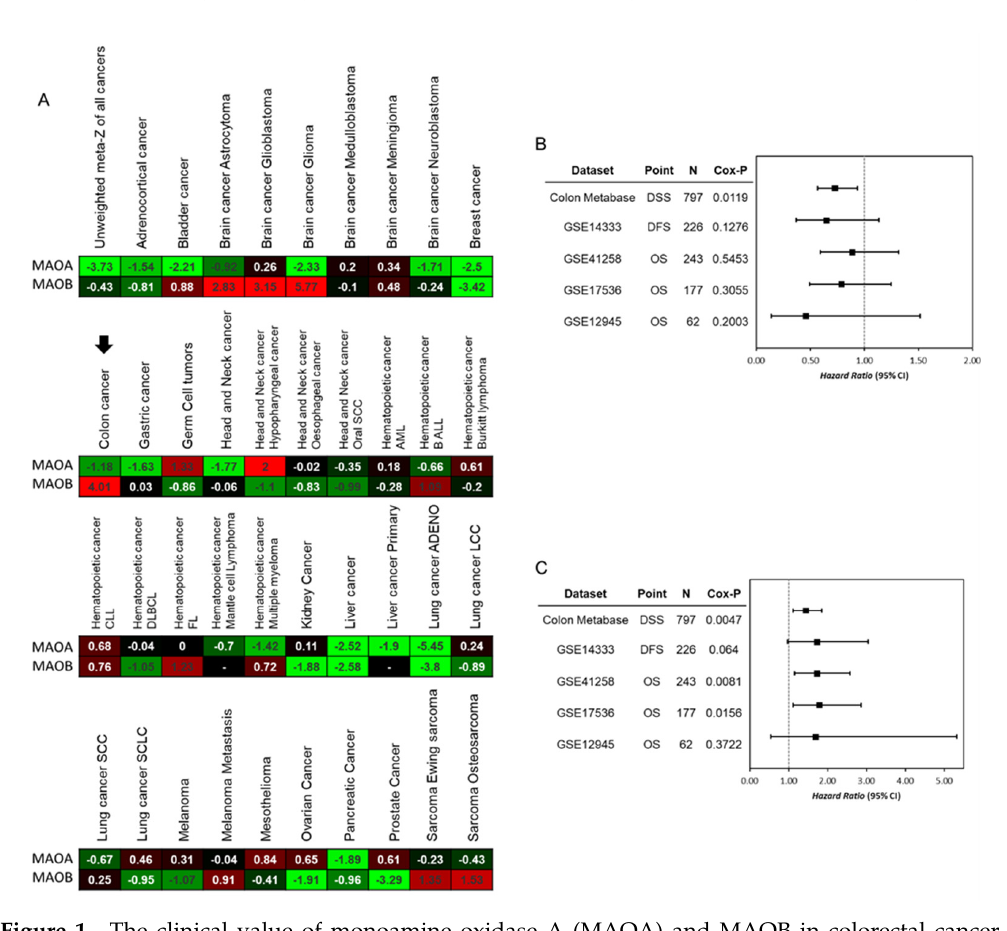
Figure 1. The clinical value of monoamine oxidase A (MAOA) and MAOB in colorectal cancer. ( A ) Visualization of the pan-cancer expression of MAOA and MAOB levels. Meta-Z analysis using the Prediction of Clinical Outcome from Genomic Profiles (PRECOG) website, which encompasses 39 distinct cancer types and 166 cancer expression datasets. ( B , C ) Forest plot showing the hazard ratios (HRs) and 95% confidence intervals for the association of MAOA ( B ) and MAOB ( C ) expression levels with disease-specific survival (DSS), disease-free survival (DFS), and overall survival (OS) in the five independent colorectal cancer (CRC) databases. The p -value was calculated.